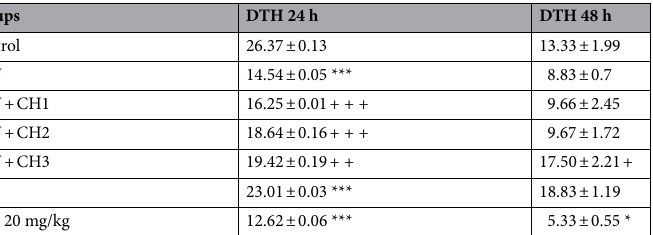
Table 3. Effect of DZN 20 mg/kg and CH 50 mg/kg, and DZN plus CH (12.5, 25, and 50 mg/kg) on DTH responses in BALB/c mice. Data showed as mean ± SD, (*) shows the significant changes compared to controls, ( +) comparison with the diazinon-treated group. p < 0.05 and (***) or (+ + + +) p < 0.001. DZN significantly reduced the DTH in sensitised animals compared to the control group after 24 h. CH at doses of 12.5, 25, and 50 mg/kg strongly neutralised the effect of DZN after 24 h. However, CH only at the highest dose of 50 mg/kg was able to neutralise the impact of DZN after 48 h on DTH responses in animals receiving DZN plus CH.